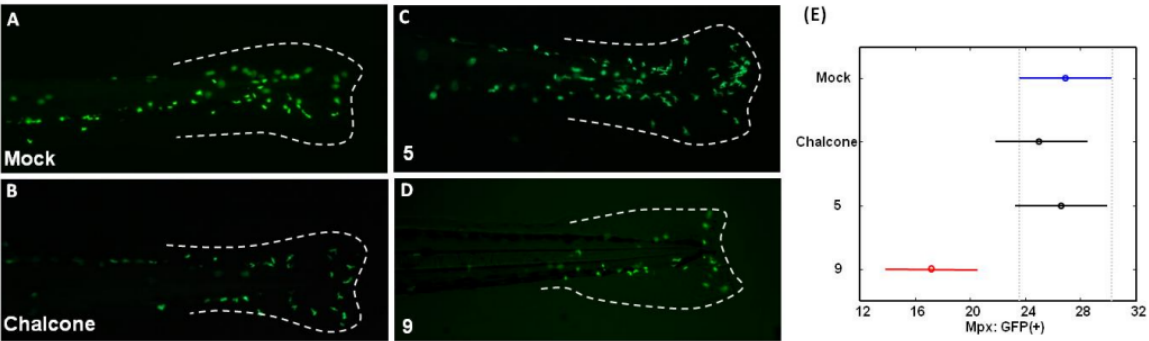
Figure 3. Myeloperoxidase (Mpx) expression in zebrafish larvae in response to wounding or chalcones (chalcone, compound 5 and 9 ) treatment. ( A – D ) The distribution of neutrophils in living Tg( mpx:gfp ) zebrafish larvae using GFP fluorescence as a marker. Dashed line outlines the region of caudal fin. ( E ) The Tukey-Kramer HSD reports the mean numbers of Mpx and their 95% confidence intervals for four treatment groups (‘Mock’, ‘chalcone’, ‘ 5 ’, ‘ 9